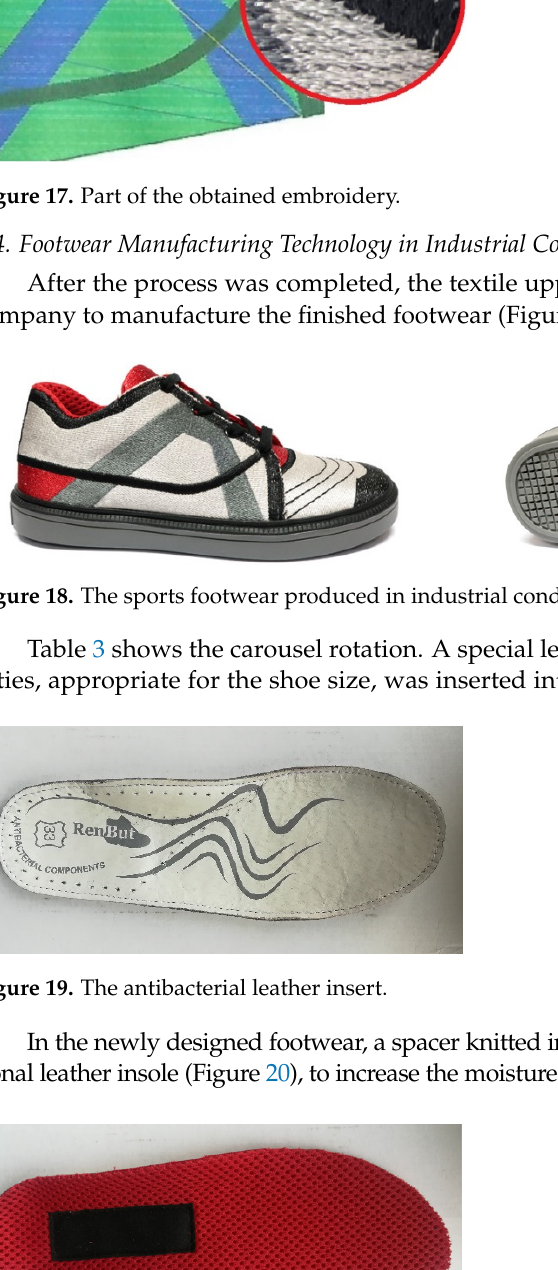
Figure 20. The footwear insert made of spacer knitted fabric.